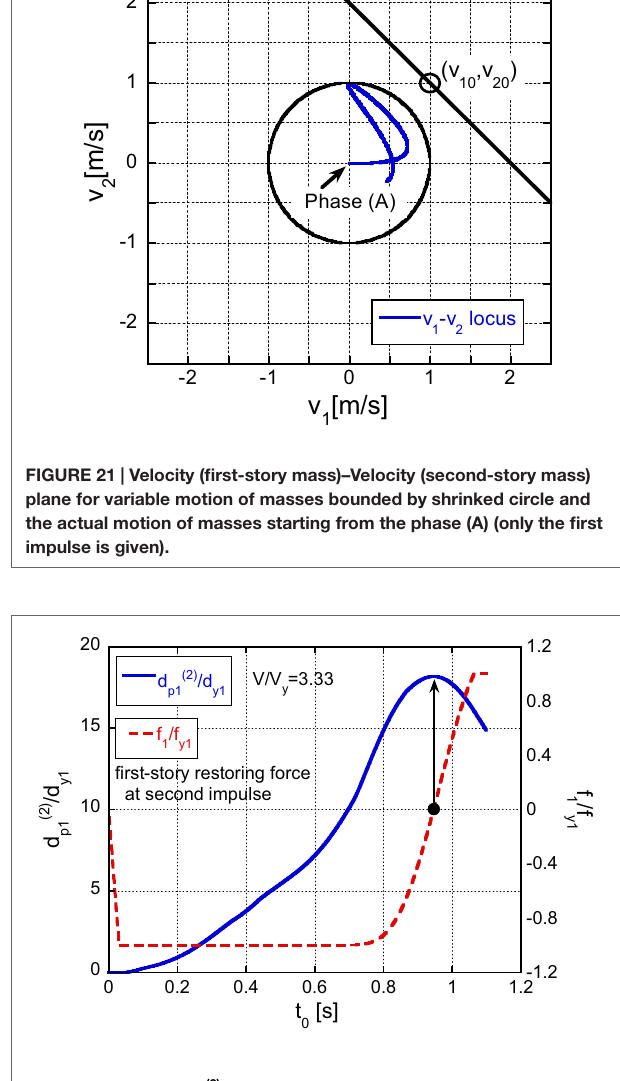
and f 1 / f y 1 (restoring force in the first story